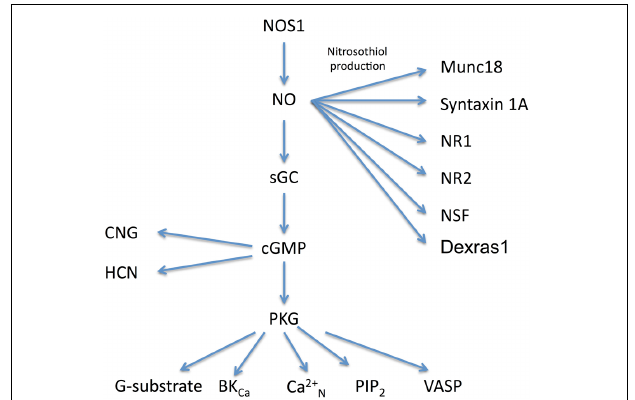
FIGURE 1 | Molecular signaling pathways for NO. The main signaling pathways described in the text for NOS1 are shown together with their effector molecules. NO has three main routes of action via nitrosothiol production, cGMP and PKG. Abbreviations: NOS1, Nitric Oxide Synthase 1; NO, Nitric Oxide; sGC, soluble guanylate cyclase; PKG, protein kinase G; G-substrate, a phosphatase inhibitor; BK Ca , large calcium sensitive potassium channel; Ca2 + N, N-type calcium channel; PIP2, phosphotidylinositol 4,5 biphosphate; VASP, vasodilator stimulated phosphoprotien; CNG, cyclic nucleotide gated channel; HCN, hyperpolarization-activated, cyclic nucleotide-modulated channel; Munc18, also known as Sec-1, is a pre-synaptic SNARE associated protein; syntaxin 1A, part of the SNARE complex; NR1, NMDA receptor subunit 1; NR2, NMDA receptor subunit 2; NSF, N-ethylmaleimide sensitive fusion protein. There is evidence for nitrosothiol production in NSF, NR1, and NR2 in vivo , but endogenous production of nitrosothiol groups in syntaxin requires